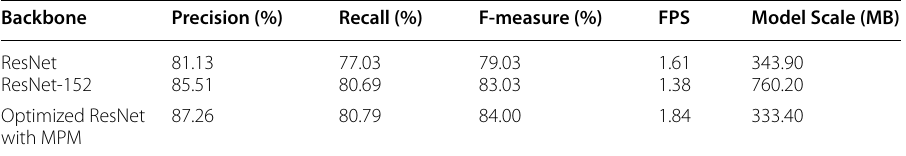
Table 2 Performance comparison of the optimized backbone network. Bold indicates that the performance ranks